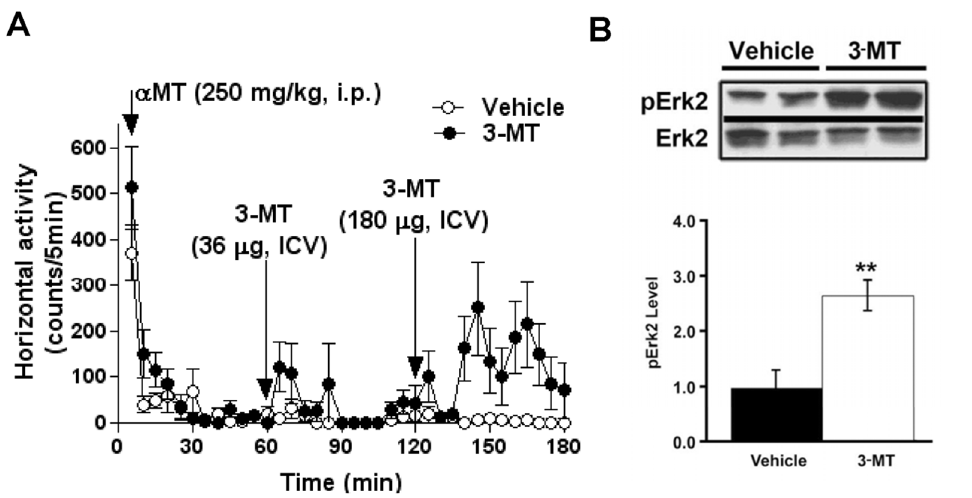
Figure 1. 3-MT induces behavioral activation and intracellular signaling in the striatum of DA deficient mice. (A) Identification of motor actions of 3-MT in DDD mice. DAT-KO mice were treated with a MT (250 mg/kg, i.p.) and 1 h after a MT were challenged repeatedly with increasing concentrations of a drug (interval between treatments is 1 h). 3-MT induced abnormal activation in DDD mice after i.c.v. infusion of both 36 and 180 m g of 3-MT (visual observations), as revealed by the significant effect of 3-MT in measures of horizontal activity at dose 180 m g (cumulative horizontal activity counts for 1 h following infusion of 180 m g 3-MT is 1711.4 6 580.1 vs. 26.8 6 11.8 in vehicle-treated group; p , 0.05, two-tailed Mann- Whitney U test, n=6 per group). (B) 3-MT administered at dose of 36 m g, i.c.v. (30 min after infusion) caused significant increase in Erk2 phosphorylation in the striatal tissue of DDD mice (n=10 per group; ** - p , 0.01; Student’s t-test).